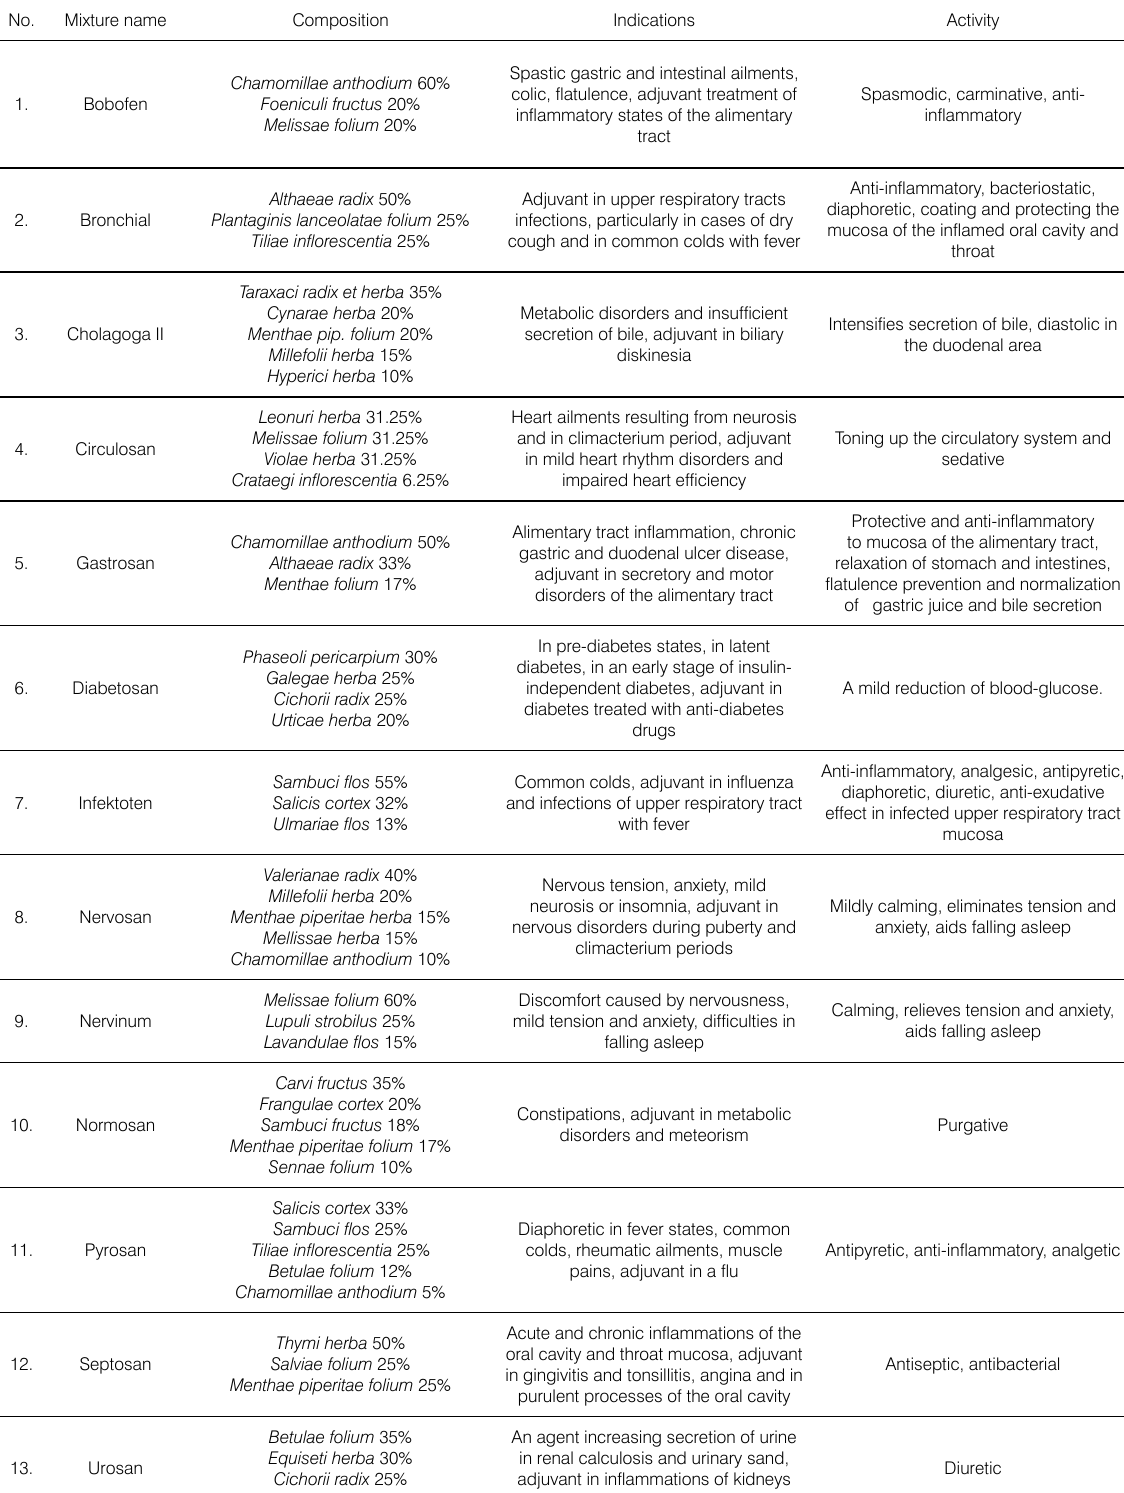
Table 1. The composition, indications and activity of herbal mixtures included in the